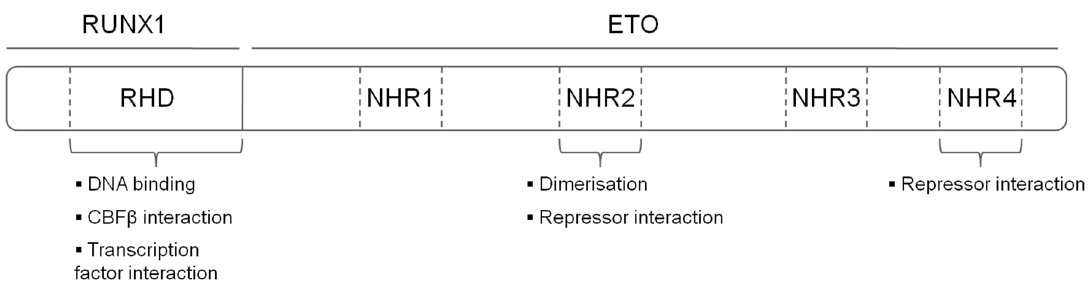
Figure 1. Structure and functional domains of the RUNX1/ETO fusion protein. RHD—Runt homology domain, NHR—nervy homology region.